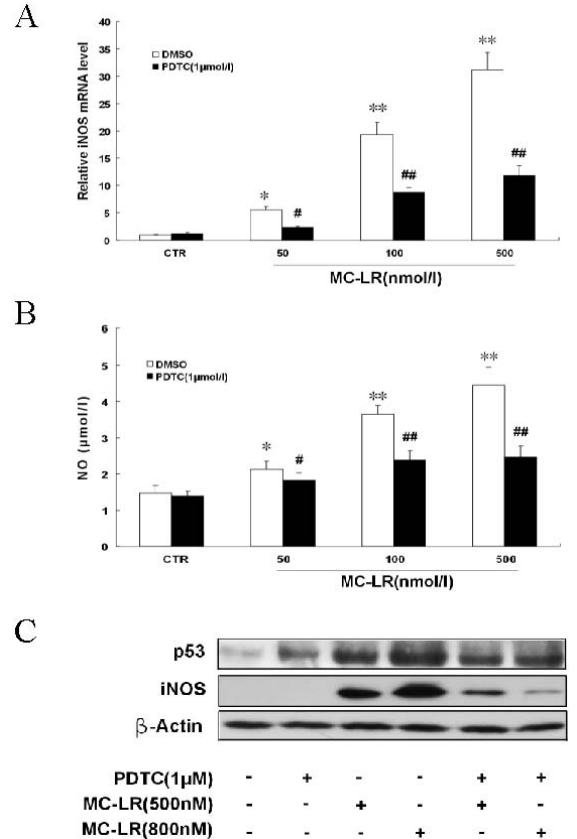
Figure 2. MC-LR accelerates intracellular nitric oxide (NO) production by